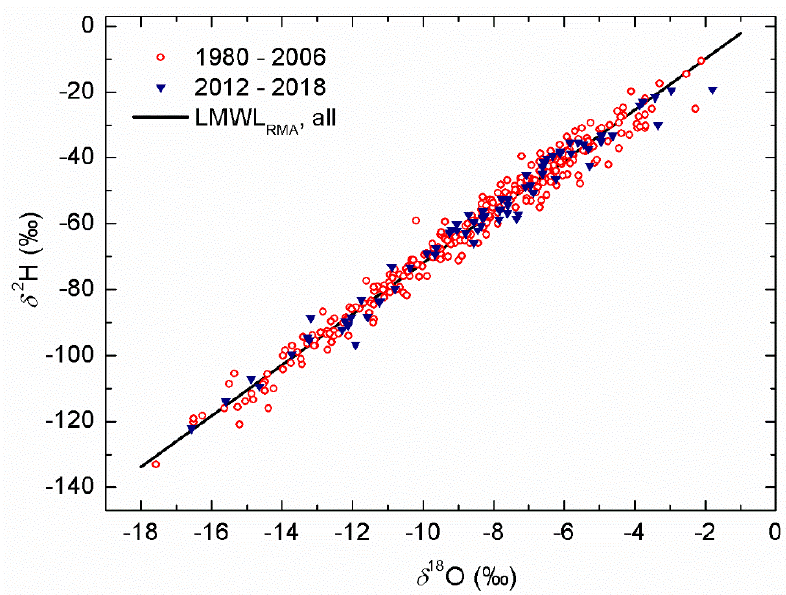
Figure 13. Local meteoric water line (LMWL) for Zagreb precipitation. Data from two periods are shown by different symbols. The fitted line is expressed by Equation (5). Table 3. Slopes ( a ) and intercepts ( b ) of the local meteoric water line (LMWL) for Zagreb in different periods and obtained using different regression methods. OLSR: ordinary least squares regression;